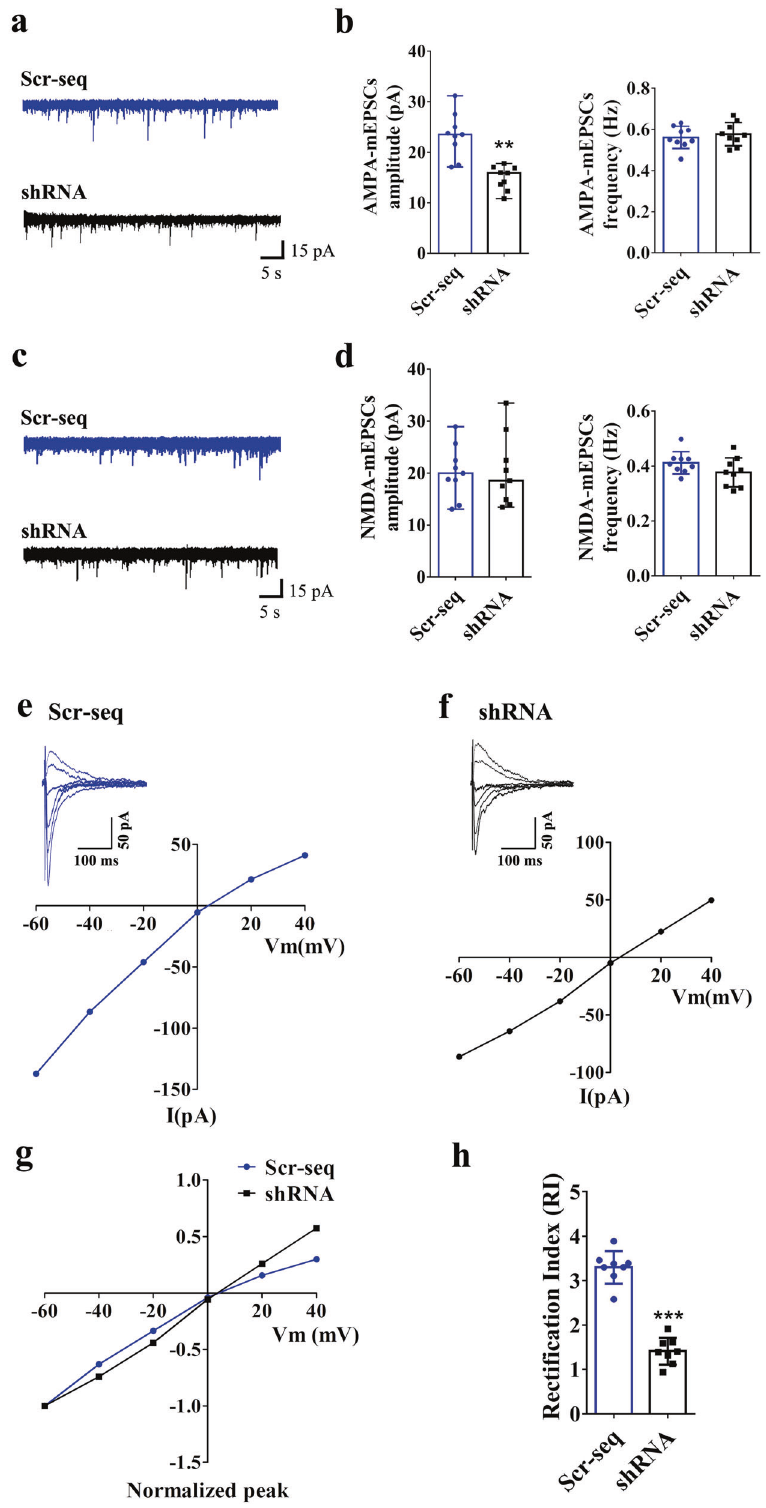
AMPAR-mediated NST by regulating CP-AMPARs. Thus, we recorded AMPAR-mediated evoked excitatory postsynaptic currents (AMPAR-eEPSCs) and compared the I – V curve of the AMPAR-eEPSCs in hippocampal CA1 neurons from the Scr-seq group and shRNA group. In recordings obtained from the Scr-seq group, the amplitude of AMPAR-eEPSCs evoked at + 40 mV